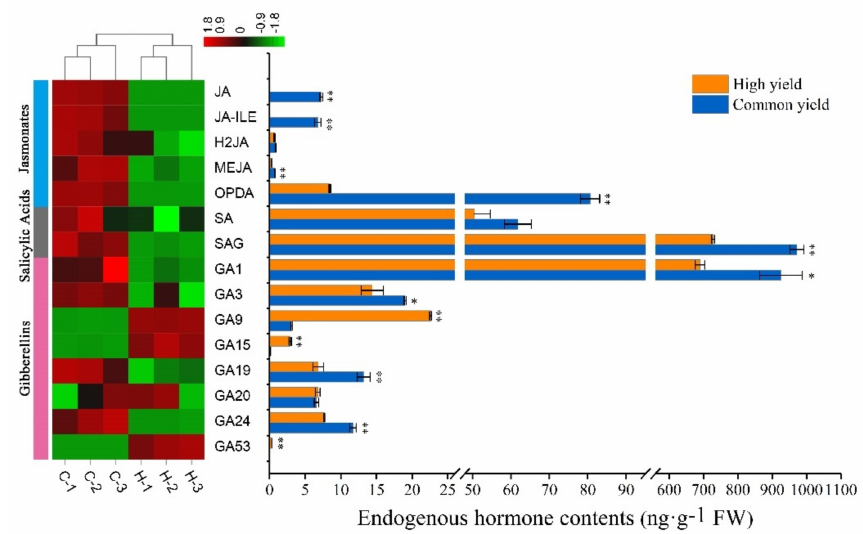
Figure 3. Endogenous hormone levels of masson pine needles in the high and common resin yield. FW means fresh weight. “Common yield” means the common resin-yielding clone, and “High yield” means the high resin-yielding clone. Error bars refer to the standard deviation (SD) of three biological repeats. * and ** indicate significant differences between the high and common ones at p < 0.05 and p < 0.01, respectively. C-1, C-2, and C-3 represent three biological repeats of the common one, H-1, H-2, and H-3 represent three biological repeats of the high one. The color brightness represents the degree of the content difference, as shown in the color bar. GA15 is too small to be seen and GA53 is too low to be detected in the common one, and JA, as well as JA-ILE, are too low to be detected in the high one. JA, jasmonic acid; JA-ILE, jasmonoyl-L-isoleucine; H2JA, dihydrojasmonic acid; MEJA, methyl jasmonate; OPDA, cis (+)-12-oxophytodienoic acid; SA, salicylic acid; SAG, salicylic acid 2-O- β -glucoside; GA1, gibberellin A1; GA2, gibberellin A2; GA3, gibberellin A3; GA4, gibberellin